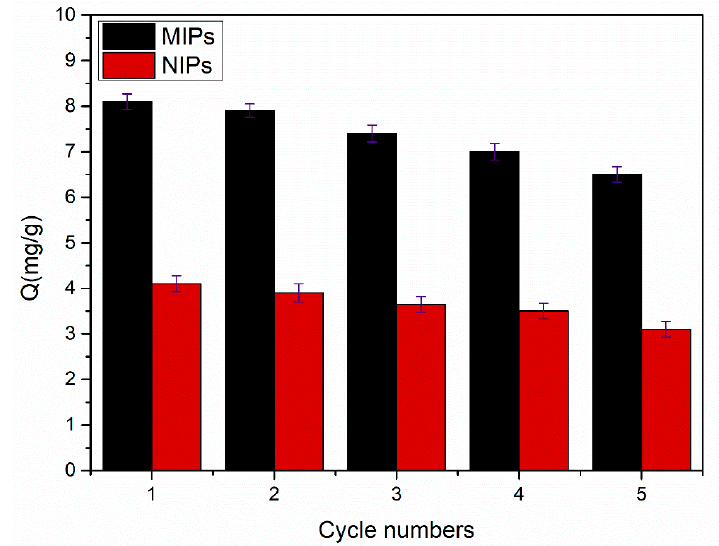
Figure 11. The recycling of MIPs and NIPs (10 mg of MIPs / NIPs in 5 mL of 0.3 mmol·L − 1 SMZ solution for 5 h). Each Q value takes the average of three measurements, and the error bars represent the SD.